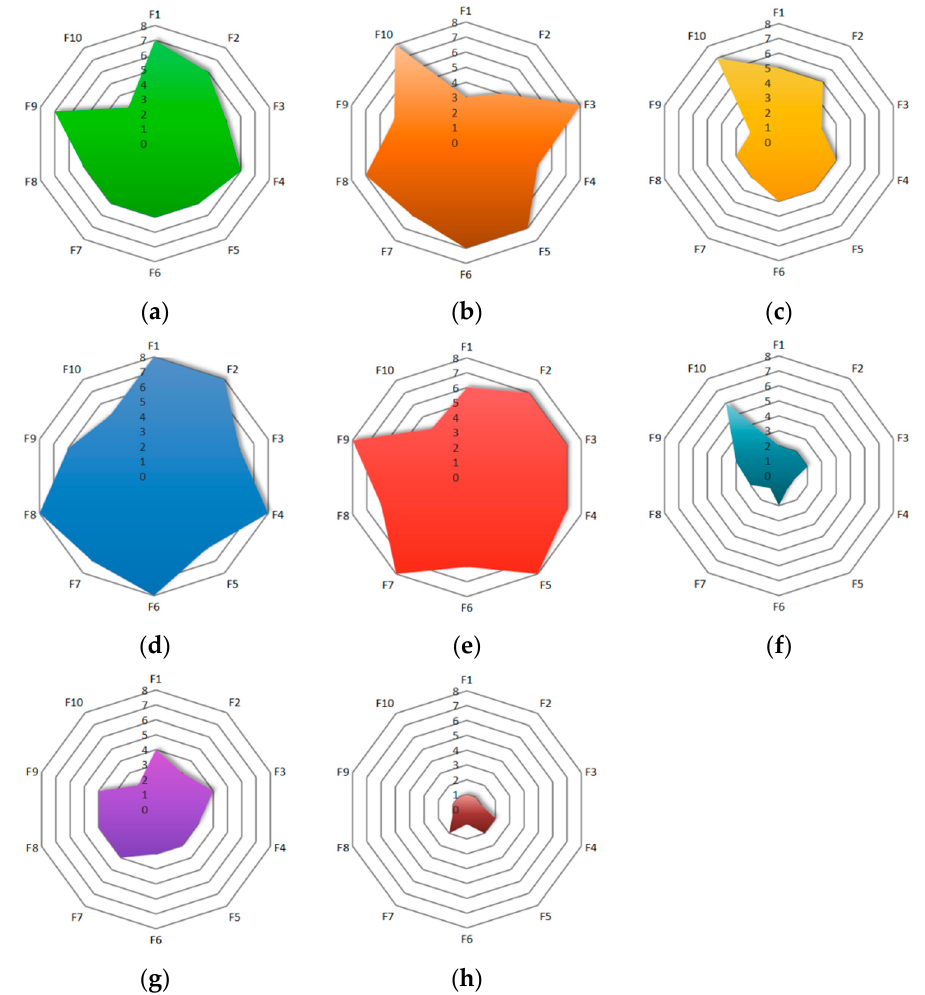
Figure 6. Radar graphs of all optimization algorithms on the CEC2019 test set. ( a ) SSA. ( b ) SOA. ( c ) PSO. ( d ) WOA. ( e ) SCA. ( f ) MTDE. ( g ) JS. ( h ) EJS.